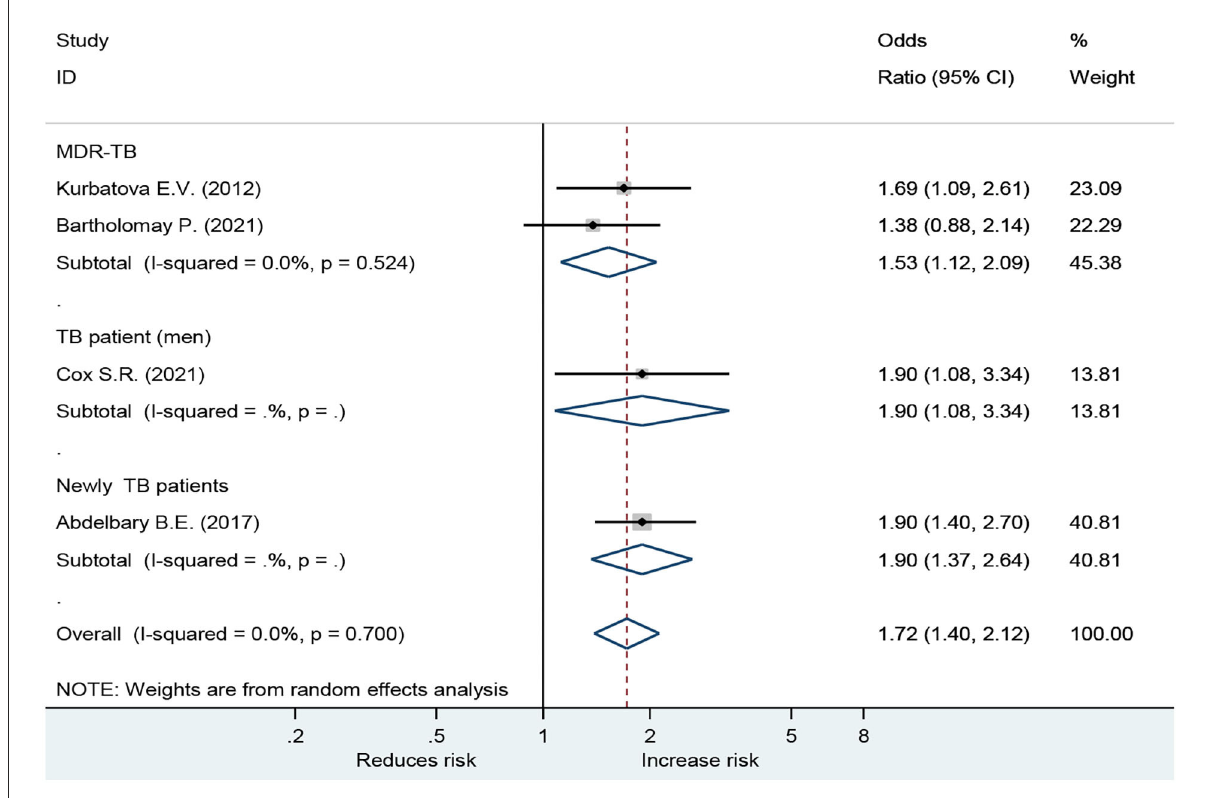
FIGURE3 Forest plot showing the effect of alcohol drinkers by tuberculosis